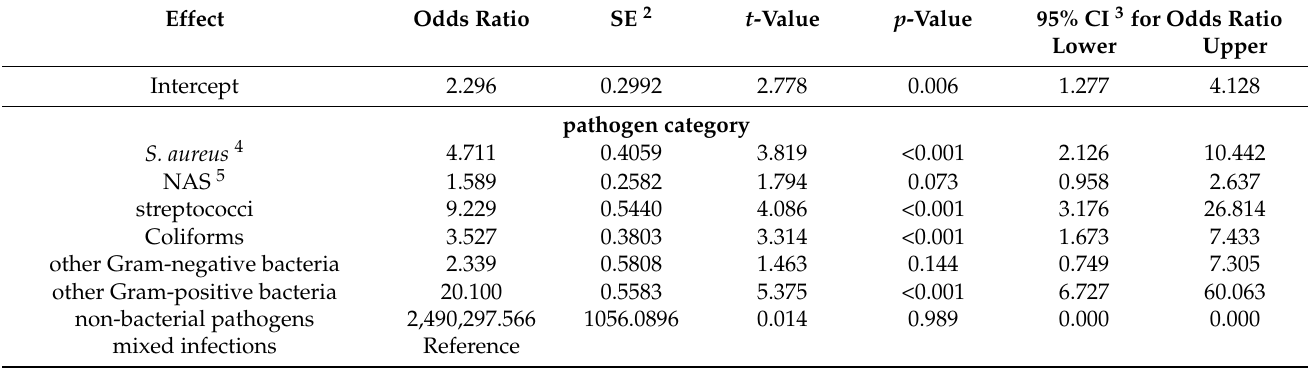
Table 3. Generalized linear mixed model for quarter level bacteriological cure during the DP 1